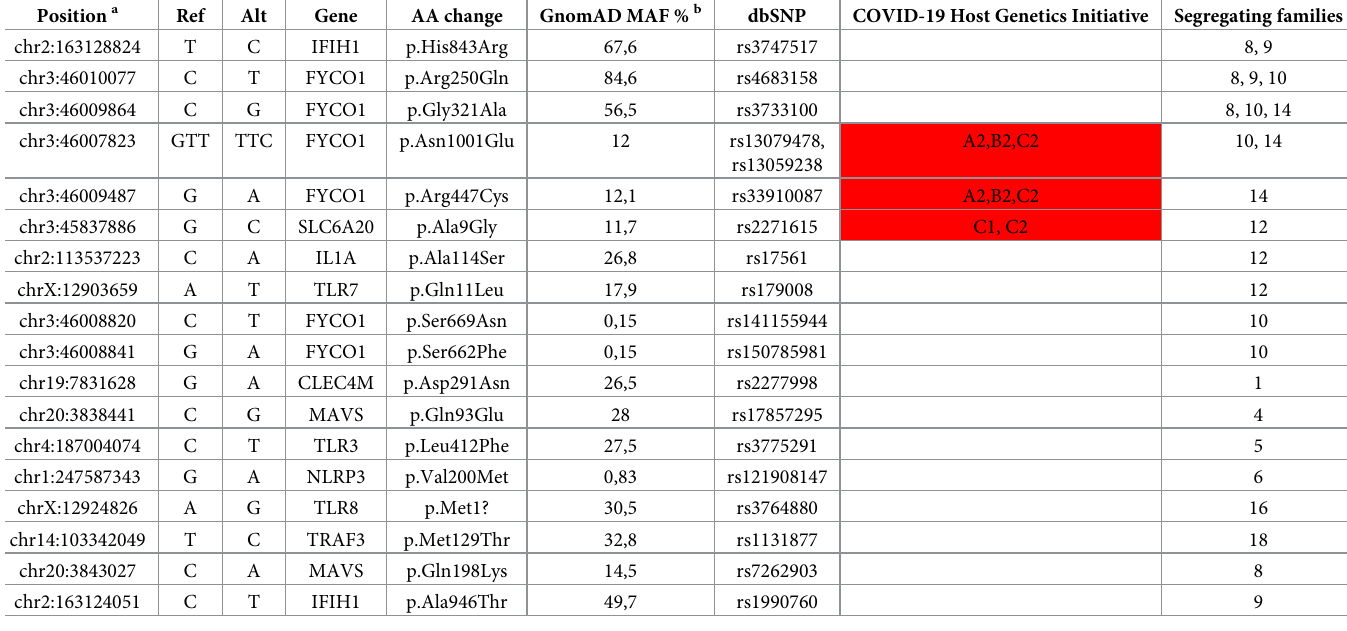
Table 2. Familial segregation of risk variants in families with positive SARS-CoV-2 test. Position